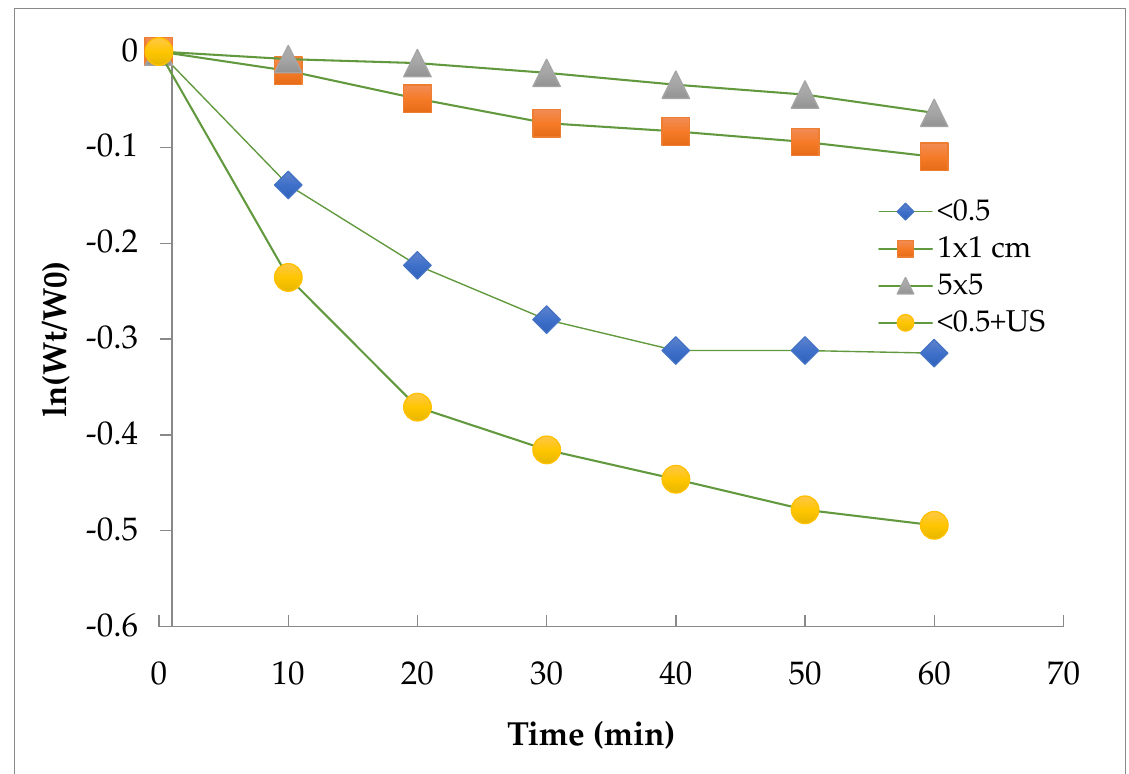
Figure 6. Detachment kinetics of adherent material by H 2 O 2 (40%) under different conditions. Nitric acid is also characterized by a strong oxidizing capacity with high redox po- tential (0.8 − 0.96 V depending on the pH); the presence of small quantities of nitrous acid ducing nitrogen oxides (NO and/or NO 2 depending on the acid concentration) and CO